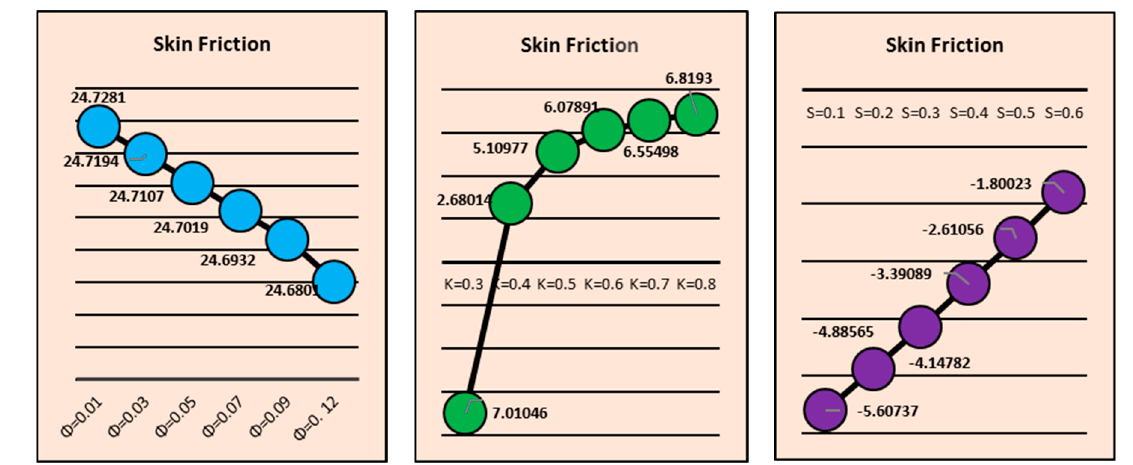
Figure 14. E ff ects of φ , k and S on the Skin friction coe ffi Figure 14. Effects of ϕ , k and S on the Skin friction coefficient. Figure 14. Effects of ϕ , k and S on the Skin friction coefficient.